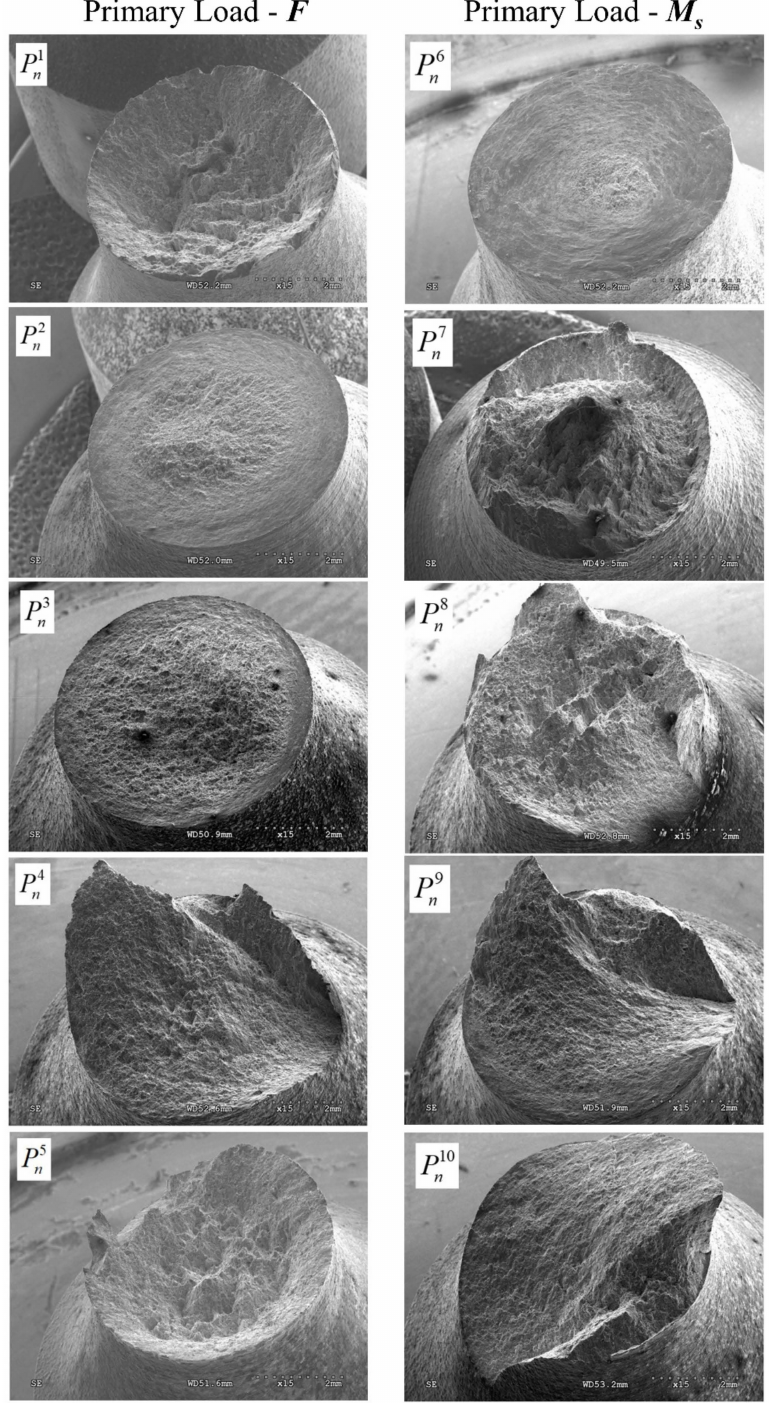
Figure 15. Fracture surface of notched specimens with a notch radius r K = 8 mm for di ff erent load